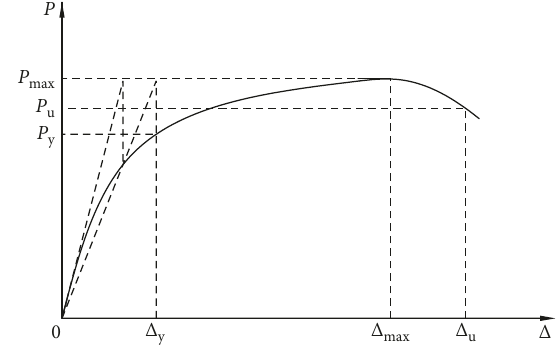
Figure 13: General yield bending moment